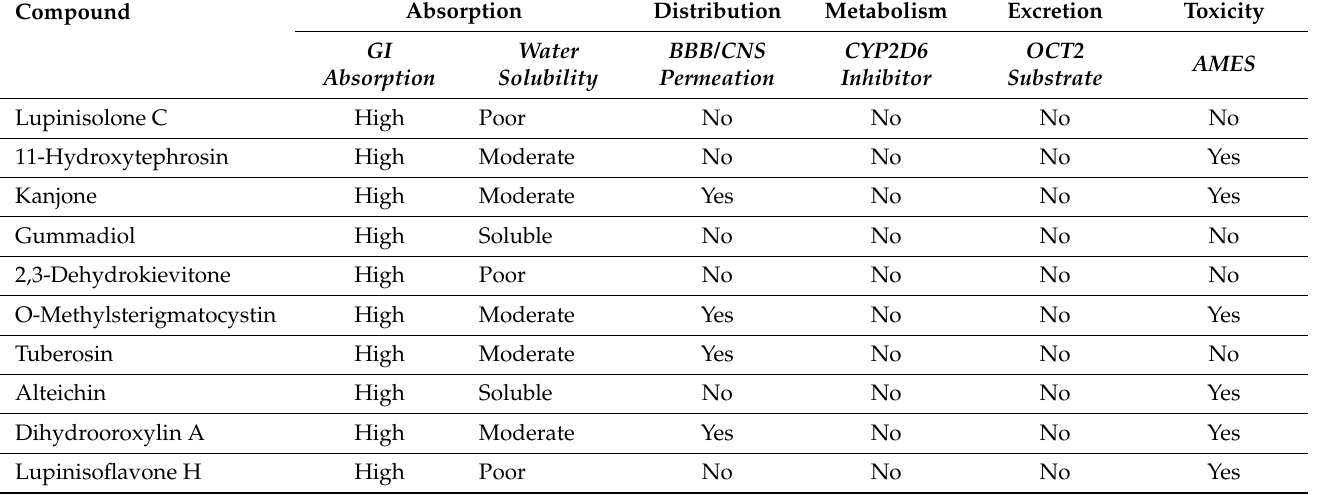
Table 2. ADMET properties of the selected compounds. GI, gastrointestinal; BBB, blood-brain barrier; CNS, central nervous system; CYP2D6, Cytochrome P450